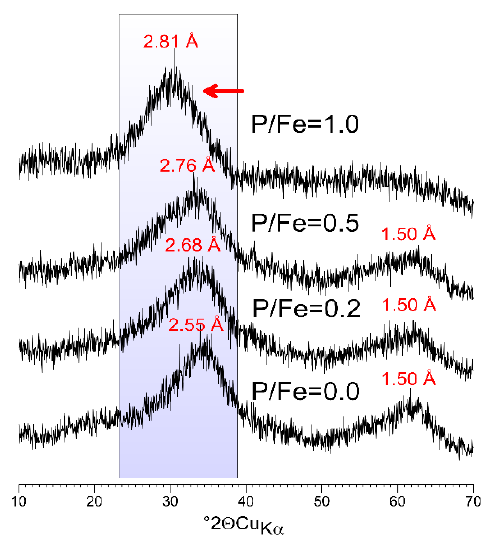
Figure 2. XRD patterns of a synthetic 2-line ferrihydrite doped with P (before heating). The increasing presence of P results in the systematic shift of the first peak toward the low angles. The second peak disappears at the highest content of P.